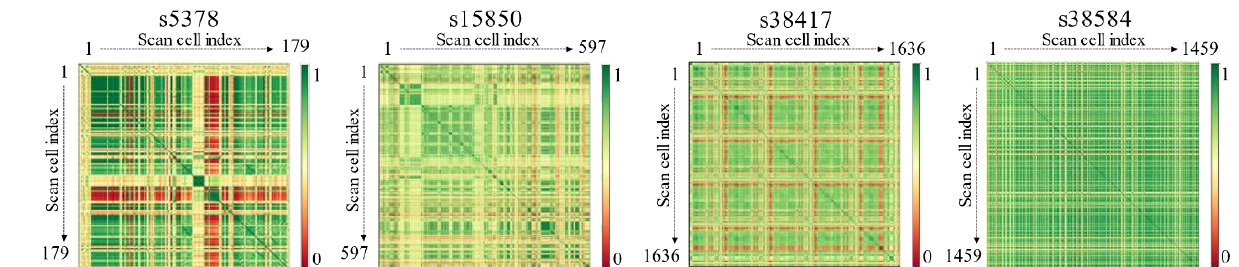
Figure 3. Heatmap graph of scan cell-to-cell correlation.